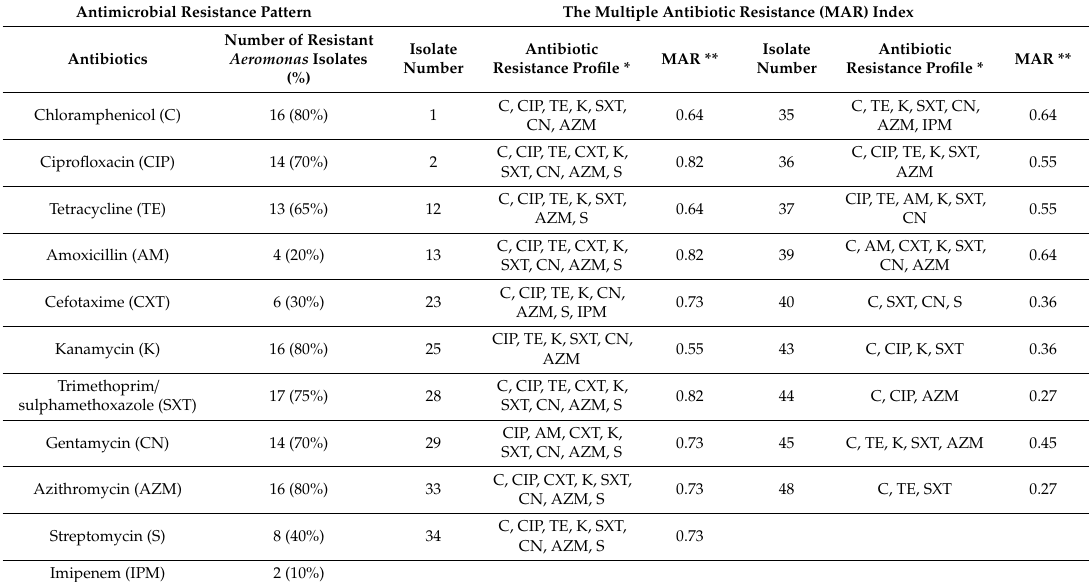
Table 7. Number and percentage of Aeromonas isolates resistant to the antibiotics and multiple antibiotic resistances (MAR) index of Aeromonas